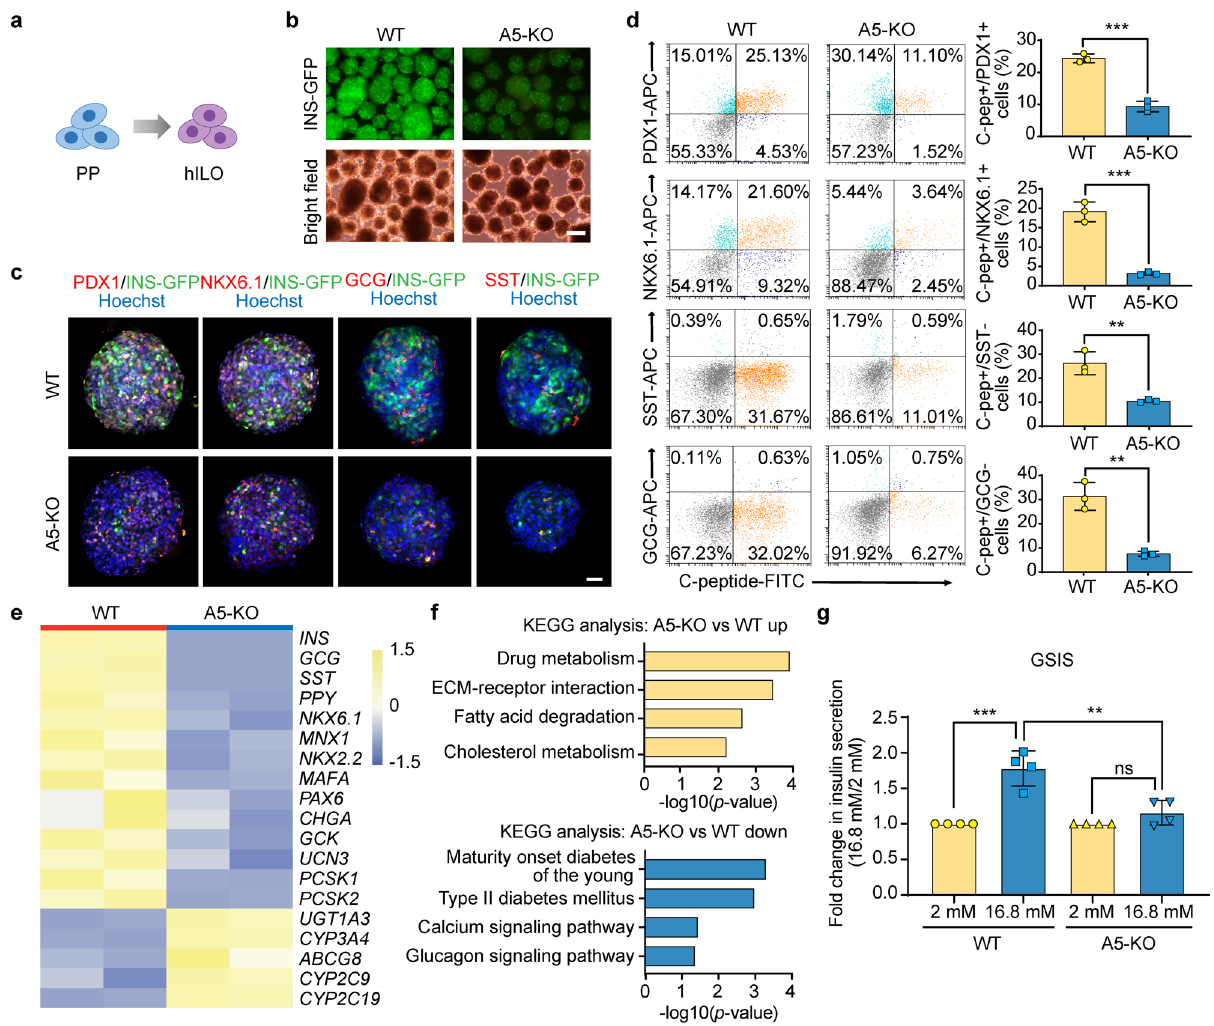
Fig. 4 ALKBH5 is required for pancreatic islet organogenesis. a A schematic representation of the generation of hILOs from PPs. b Representative fl uorescence images of INS-GFP-positive pancreatic β -like cells in WT and A5-KO hILOs. Images are representative of four independent replicates. Scale bar, 200 μ m. c Representative immuno fl uorescent images of WT and A5-KO hILOs stained for PDX1, NKX6.1, GCG, SST, and nuclei. Scale bar, 100 μ m. Images are representative of three independent replicates. d Representative fl ow cytometry plots and the percentage of PDX1 + C-peptide + , NKX6.1 + C-peptide + , SST - C-peptide + , and GCG - C-peptide + cells in WT and A5-KO populations ( n = 3 biological replicates). e Heatmap visualization of marker gene expression. f KEGG analysis of upregulated and downregulated genes. p -values were calculated by one-tailed hypergeometric test. g The